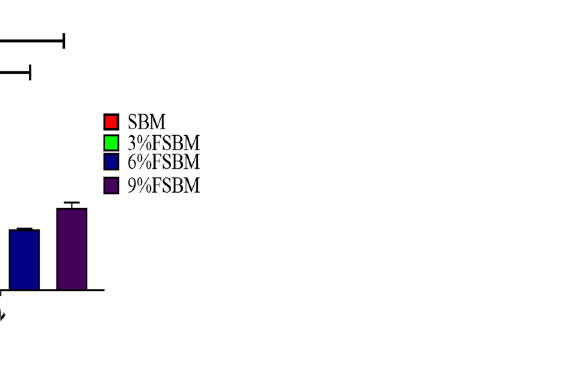
Figure 2. Effect of fermented soybean meal (FSBM) on diarrhea rate in piglets. Data are presented as means ± SD. * P < 0.05, ** P < 0.01. SBM, soybean meal; FSBM, fermented soybean